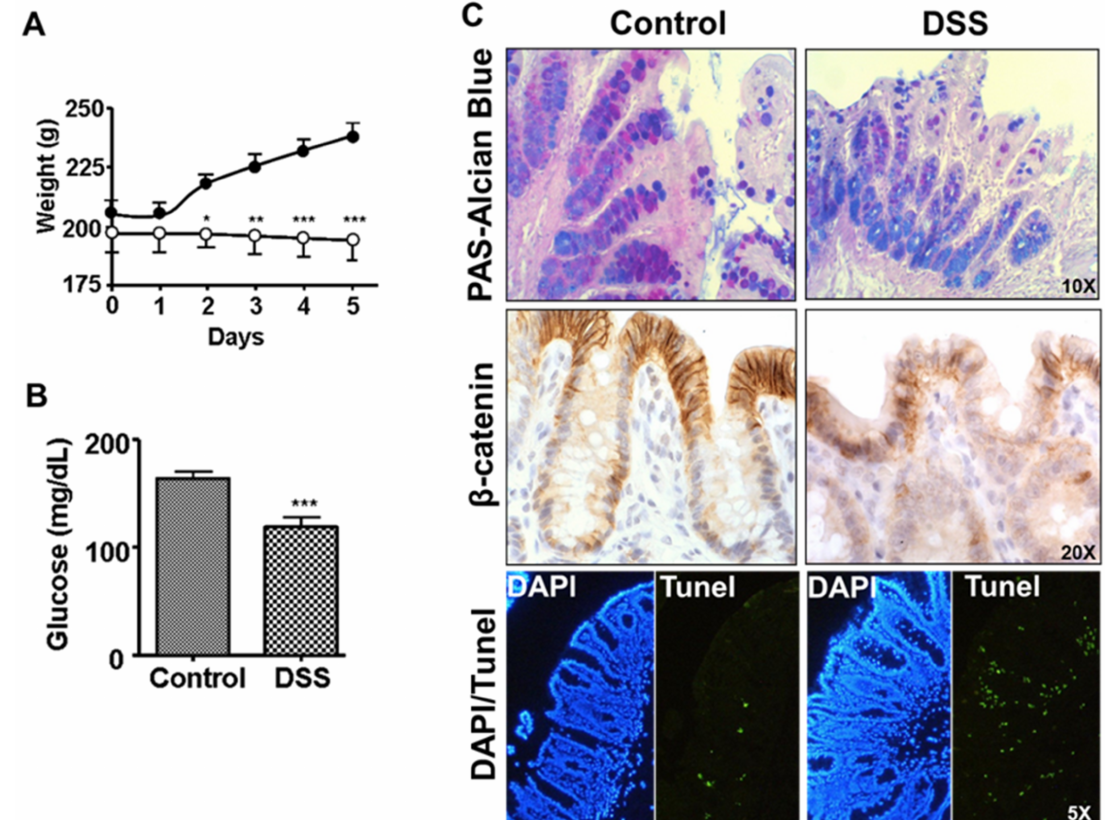
Figure 1. General analysis of the state of the rats with colitis. ( A ) Evolution of the weight of the animals during the colitis induced by DSS. ( B ) Blood glucose levels after 5 days of treatment with DSS. ( C ) Histological study of the colon after 5 days of treatment with DSS. The expression of mucin, β -catenin levels and apoptosis were studied. Significance levels: * p < 0.05; ** p < 0.01; *** p <